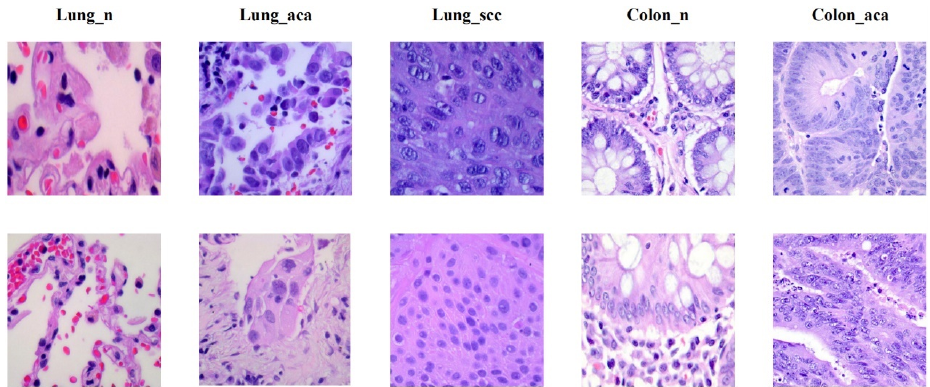
Figure 7. Dataset LC25000. From left to right: benign lung pathology image (Lung_n), lung adenocar- cinoma pathology image (Lung_aca), lung squamous carcinoma pathology image (Lung_scc), benign colon pathology image (Colon_n) and colon adenocarcinoma pathology image (Colon_aca), and the image size is 768 ×